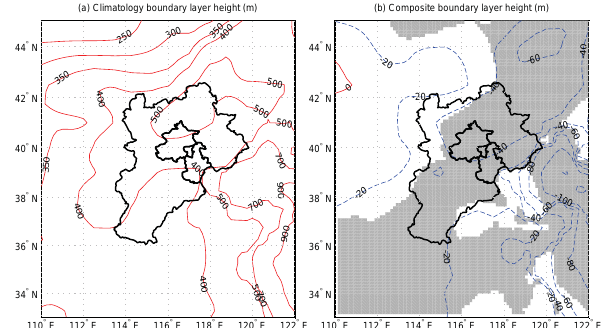
Figure 10. The climatological mean (a) and the composite (b) boundary layer height (areas significant at the 0.05 level are